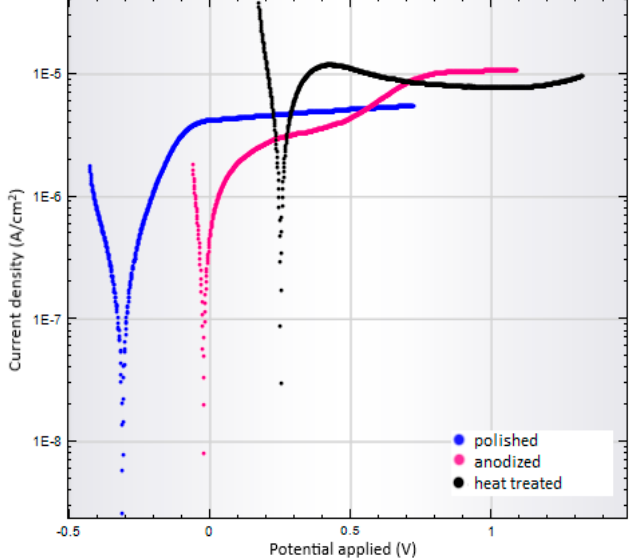
Figure 10. Polarization curves of a polished, as-anodized, and anodized-heat treated Ti6Al4V samples.